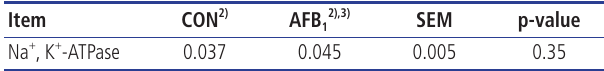
on average relative 1